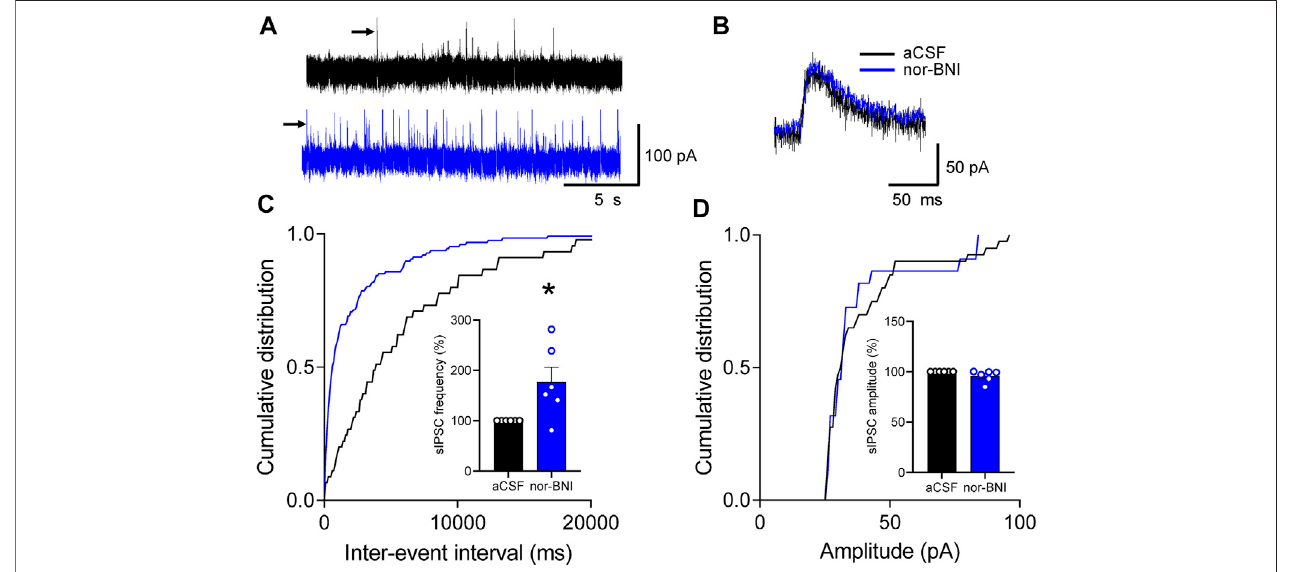
FIGURE7| EffectsofaKORantagonistonspontaneousIPSCs(sIPSCs)inCRF-CeAneuronsinafunctionalpainmodel.Recordingsofvisuallyidenti fi edCeA-CRF neurons were made in whole-cell con fi guration. (A) Voltage-clamped (at 0 mV) traces of sIPSCs during application of aCSF (vehicle) and nor-BNI (1 μ M). (B) Expanded tracesofindividual sIPSCs (indicated by arrows inA) show thatnor-BNI did notaffectchannel kinetics. (C,D) Analysisoffrequency(inter-eventinterval) and amplitude of sIPSCsrecordedinanindividualneuronshowssigni fi cantlyincreasedsIPSCfrequencybynor-BNI(* p < 0.05,paired t -test,comparedtopredrugaCSF, n =6; (C) , but no signi fi cant effect on sIPSC amplitude ( p > 0.05, paired t -test, compared to aCSF predrug control, n = 6; (D) . Bar histograms show means ± SEM. Symbols show values of individual neurons.